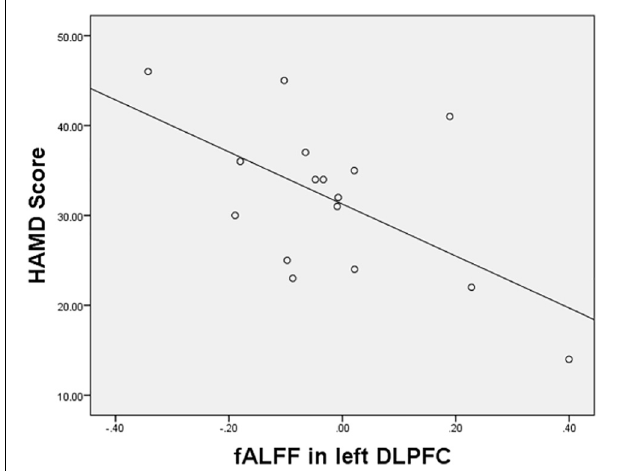
FIGURE 3 | Correlations between the HAMD scores and increased fALFF values in the left